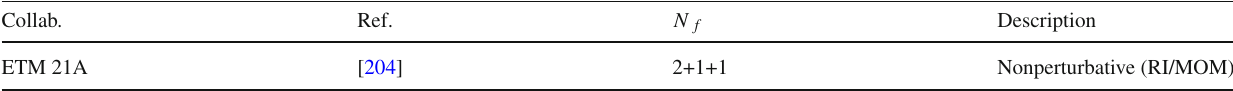
Table 101 Lattice renormalization in the determinations of m b with N f = 2 + 1 + 1 flavours Collab. Ref.